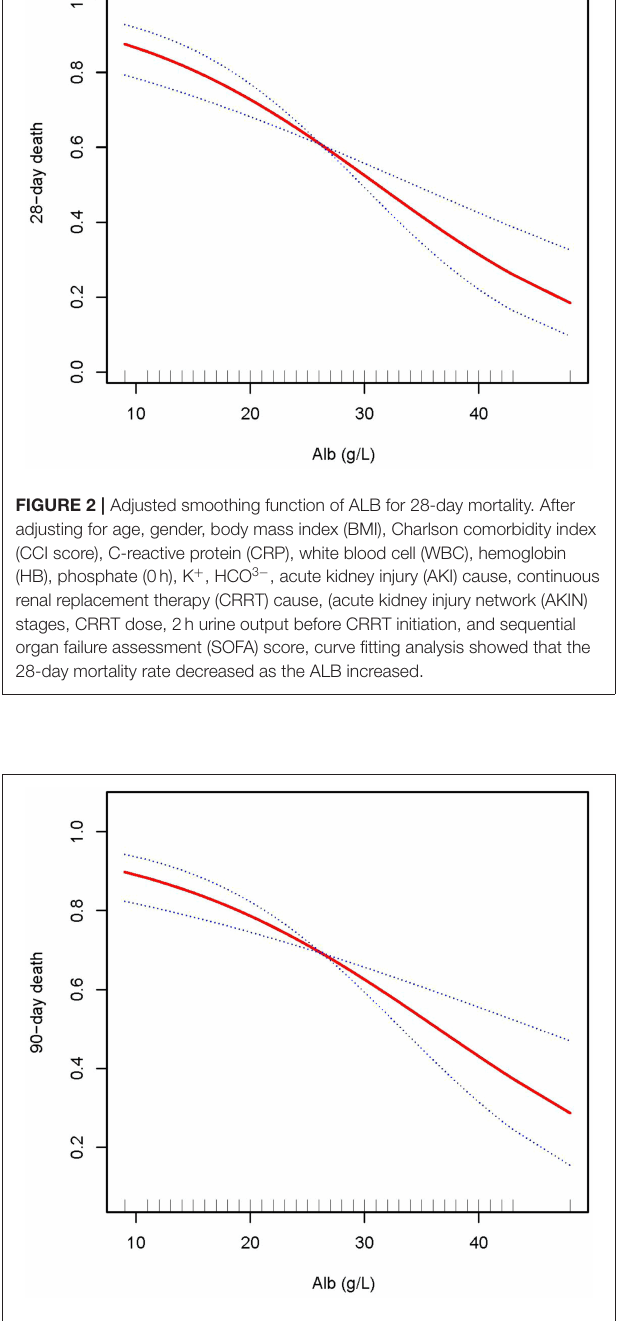
FIGURE 3 | Adjusted smoothing function of ALB for 90-day mortality. After adjusting for age, gender, body mass index (BMI), Charlson comorbidity index (CCI score), C-reactive protein (CRP), white blood cell (WBC), hemoglobin (HB), phosphate (0h), K + , HCO 3 − , acute kidney injury (AKI) cause, continuous renal replacement therapy (CRRT) cause, (acute kidney injury network (AKIN) stages, CRRT dose, 2h urine output before CRRT initiation, andsequential organ failure assessment (SOFA) score, curve fitting analysis showed that the 90-day mortality rate decreased as the ALB increased.